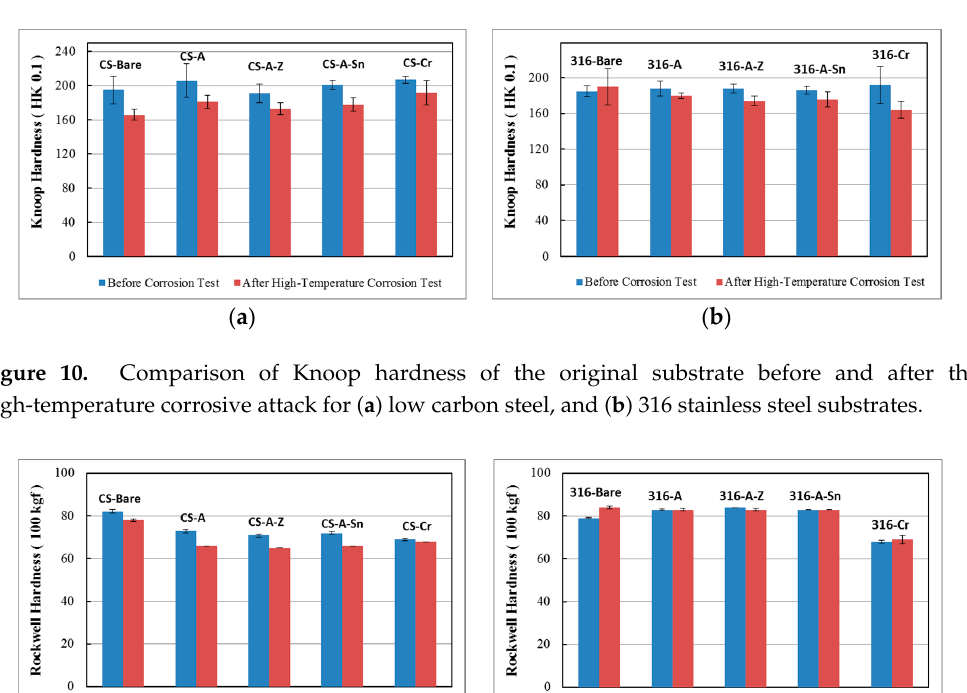
Figure 11. Comparison of Rockwell hardness of the original substrate before and after the high-temperature corrosive attack for ( a ) low carbon steel, and ( b ) 316 stainless steel substrates.